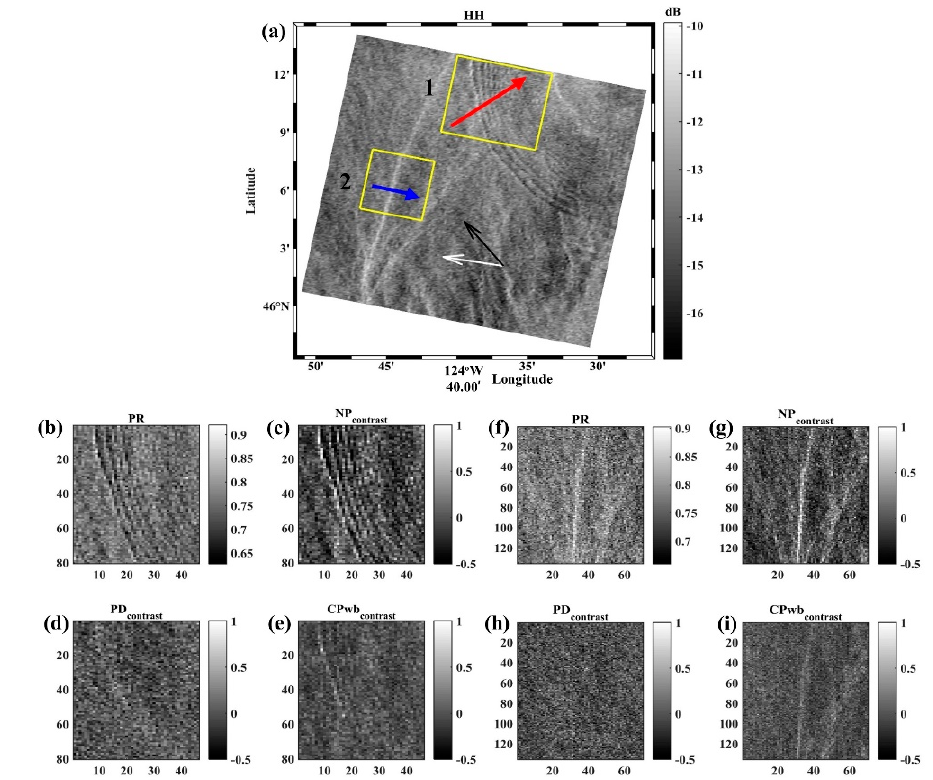
Figure 3. SAR images containing a oceanic internal solitary wave (IW) and a train of IWs: ( a ) RS-2 SAR HH-polarized images (dB units) of an area of the West Coast of USA acquired at 14:35 UTC on August 15, 2009. The key parameters associated with the enlarged region of the yellow fragment in ( a ) are estimated as: ( b , f ) PR (linear units); ( c , g ) NP contrast; ( d , h ) PD contrast; ( e , f ) CPwb contrast. The incidence angle, averaged wind speed and the angle between radar look direction and wind direction are about 29 degrees, 6 m / s and 39 degrees, respectively. RS-2 data are a product of MacDonald, Dettwiler, and Associates, Ltd. All rights reserved.